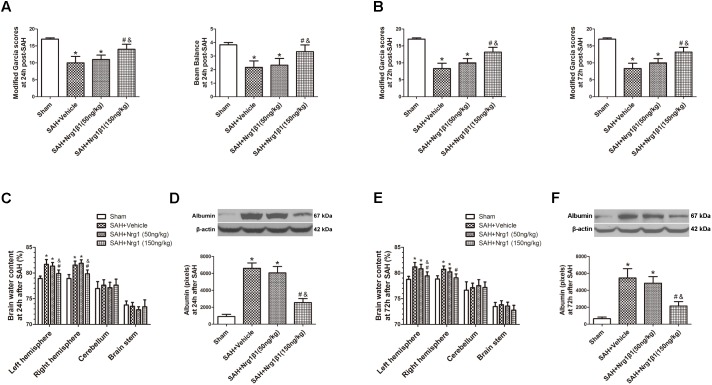
Neuregulin1 isoformβ1 (Nrg1β1) treatment improved neurological functions, reduced brain water content and deceased albumin leakage at 24 and 72 h after SAH. Neurological impairment (A,B), increased brain water content (C,E) and albumin extravasation (D,F) were found in the SAH + Vehicle groups. Nrg1β1 (150 ng/kg) treatment significantly alleviated neurological deficit (A,B), reduced brain water content (C,E) and deceased albumin extravasation (D,F). n = 6 for each group. ∗p < 0.05 versus sham; #p < 0.05 versus SAH + vehicle; &p < 0.05 versus SAH + Nrg1β1 (50 ng/kg).